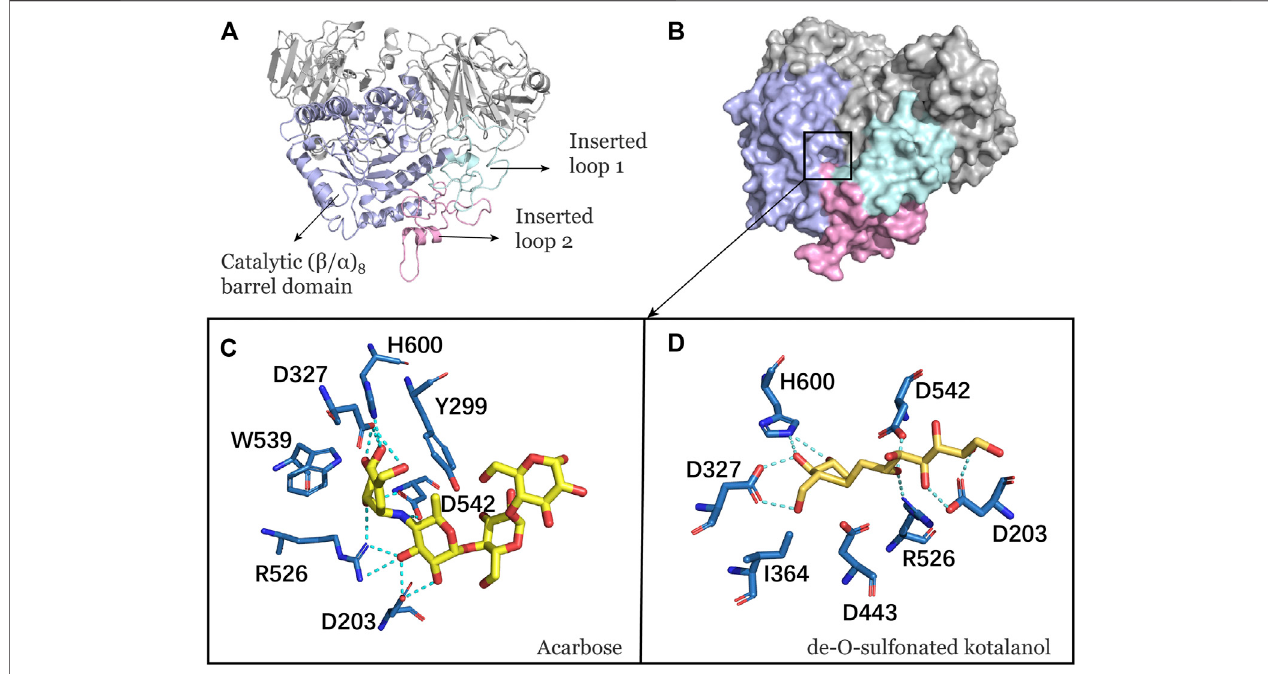
FIGURE 1 | (A) Catalytic domain of NtMGAM. The catalytic ( β / α ) 8 barrel domain is tagged and colored differently. (B) Surface diagram of NtMGAM. (C) Binding of acarbosetoNtMGAM.TheactiveresiduesaroundacarbosebindingtoNtMGAM. (D) BindingofDSKtoNtMGAM.TheactiveresiduesaroundDSKbindingtoNtMGAM.